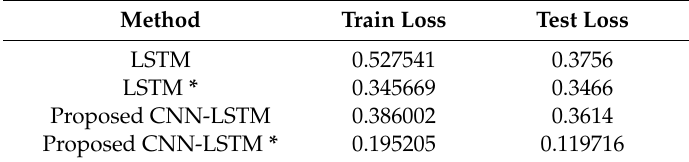
Table 2. Performance comparison with other deep learning-based models.